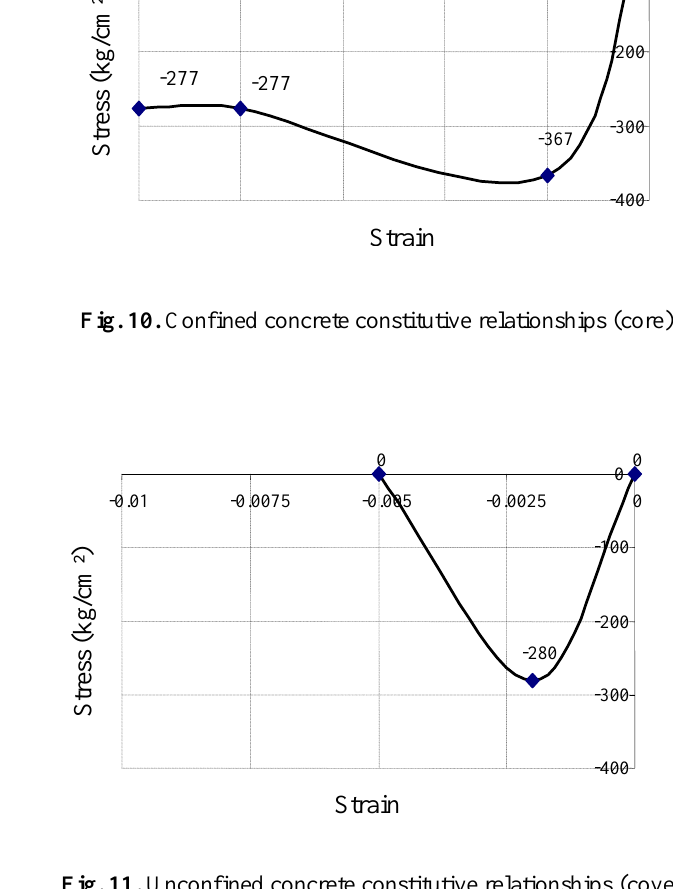
Fig. 11. Unconfined concrete constitutive relationships (cover).